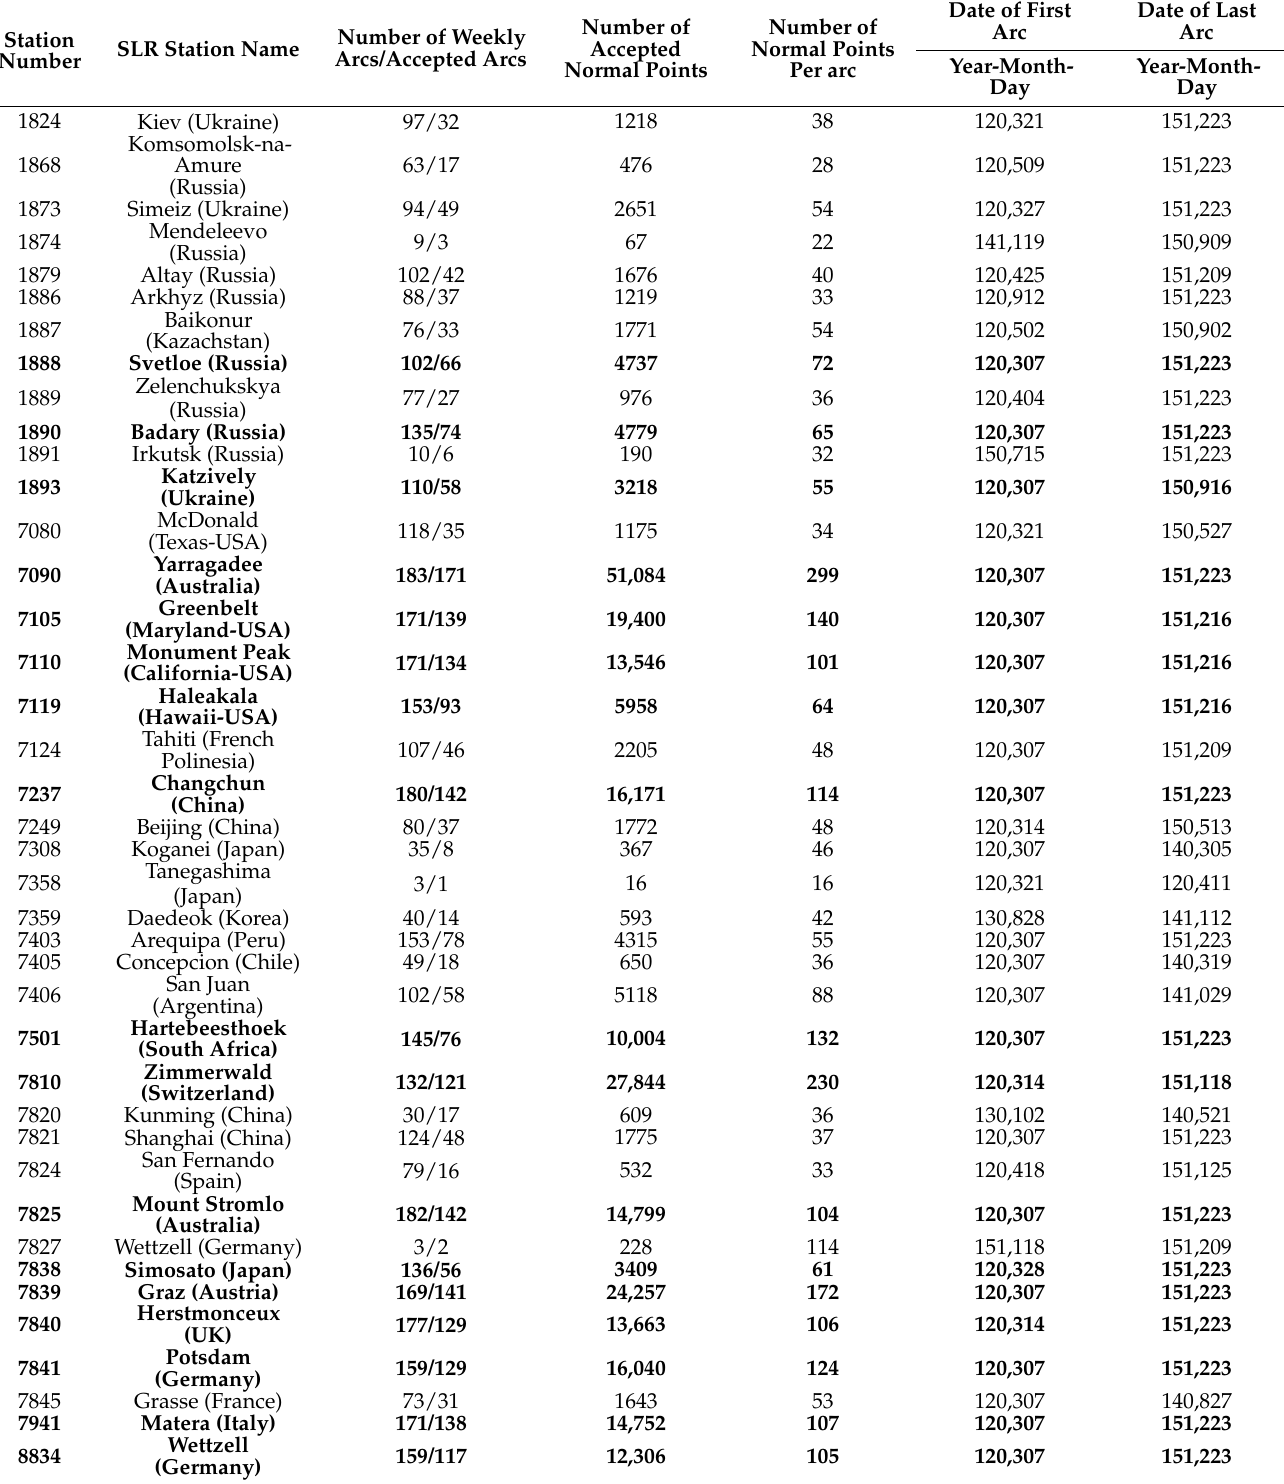
Table 3. List of all SLR stations which observed the LARES from 29 February 2012 to 31 December 2015. Lines in bold: core